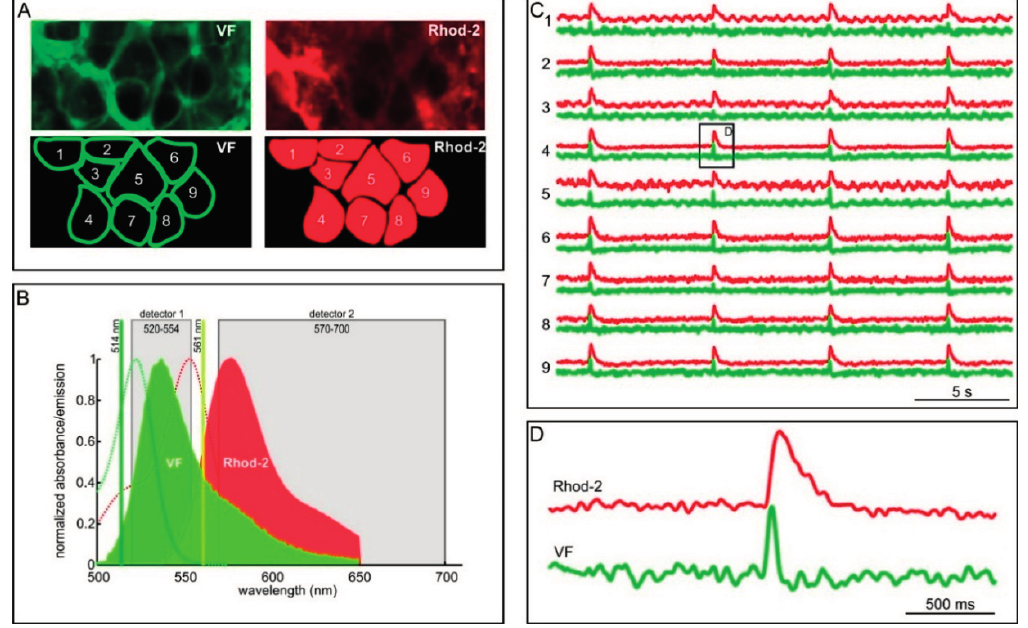
Figure 3. Simultaneously measuring changes in membrane potential using VF and changes in [Ca 2+ ] i dynamics using Rhod-2. ( A ) The voltage-sensitive dye VF preferentially labels membranes (upper left), which enables to discriminate single cells (lower left). The [Ca 2+ ] i sensitive dye Rhod-2 labels intracellular compartments (upper right). The VF-obtained outlines of cells were used to discriminate Rhod-2 signal of single cells. Numbers are used to indicate cells whose temporal traces are shown in C; ( B ) representation of the experimental setup: two laser lines and two state-of-the-art detectors were used to discriminate signals emitted from VF and signals emitted from Rhod-2; ( C ) [Ca 2+ ] i dynamics (red) obtained from 9 cells of a single islet were correlated to simultaneously obtained MP dynamics (green) from the same cells during stimulation with 12 mM glucose and 10 mM tetraethylammonium (TEA). Traces are numbered according to labels in A; and ( D )